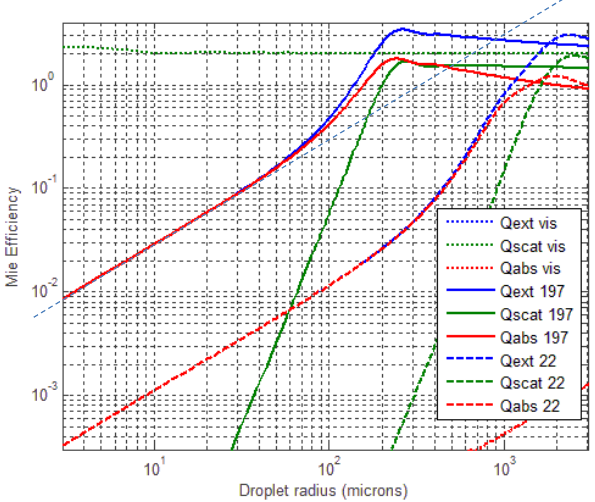
Fig. 16. Mie scattering efficiency at 22GHz, 197GHz and visible wavelengths versus the water droplet radius in microns. The index of refraction of the water used here is 5.5+2.9i, 2.83+1.24i and 1.3+1e-8 i at 22GHz, 197GHz and visible light respectively. The thin blue dashed line shows Rayleigh behavior at 197GHz extrapo- lated to larger radii. At r =0.25 mm, the 197GHz extinction due to Mie scattering and absorption is approximately 5 times larger than the extrapolated Rayleigh regime behavior. A typical cloud particle has a radius of 5 microns.